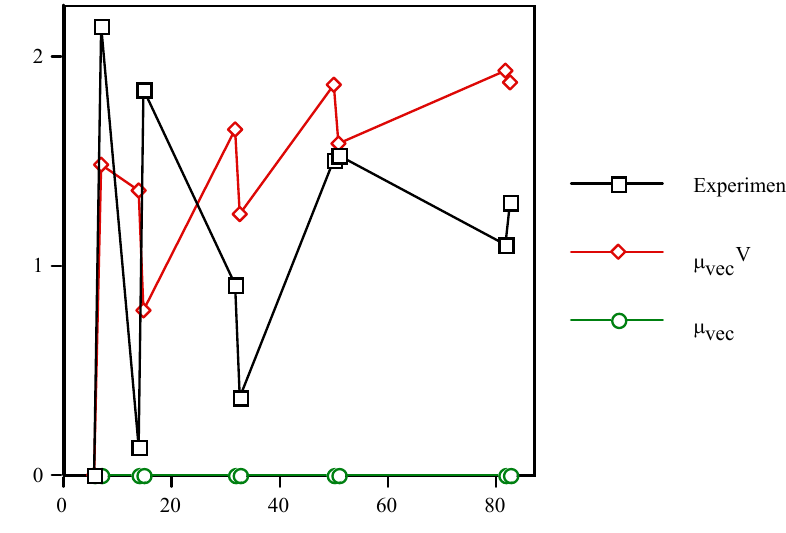
Figure 1. Dipole moment of the valence-isolectronic series of benzene vs . the atomic number of the heteroatom. Experimental data from Reference 40. Points with Z = 14, 15, 32, 33, 50, 51, 82 and 83 are AM1